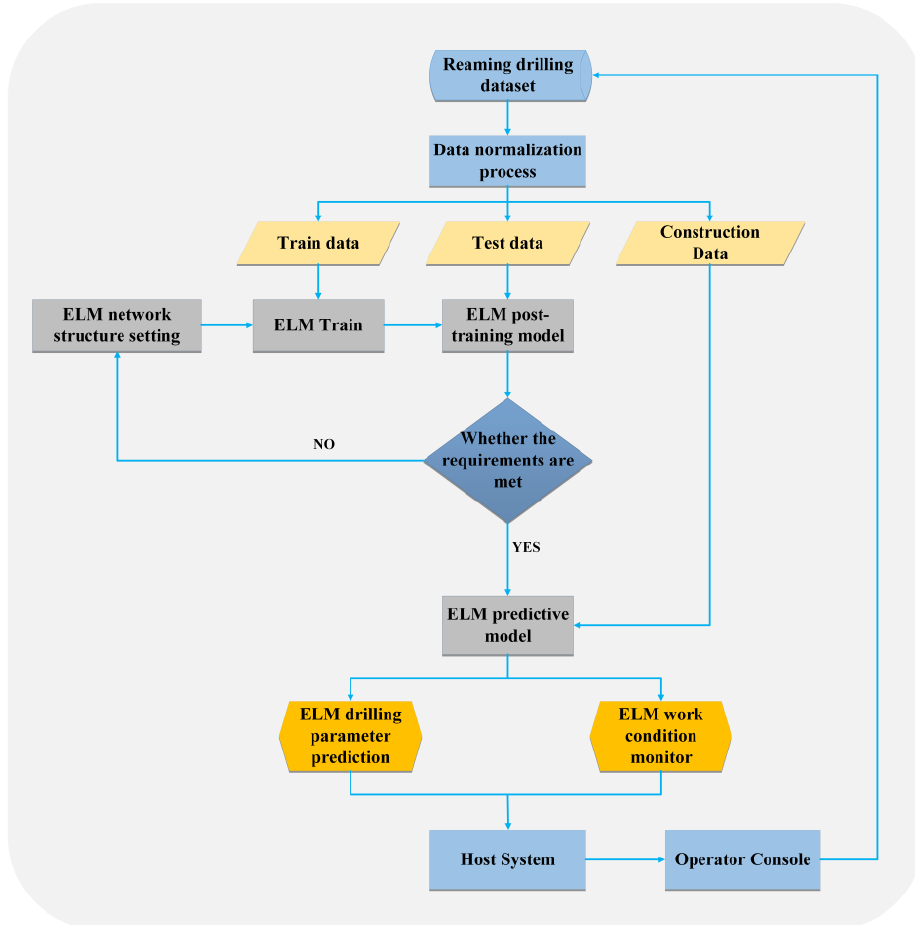
Figure 5. Flow chart of the intelligent predictive control for reaming up.